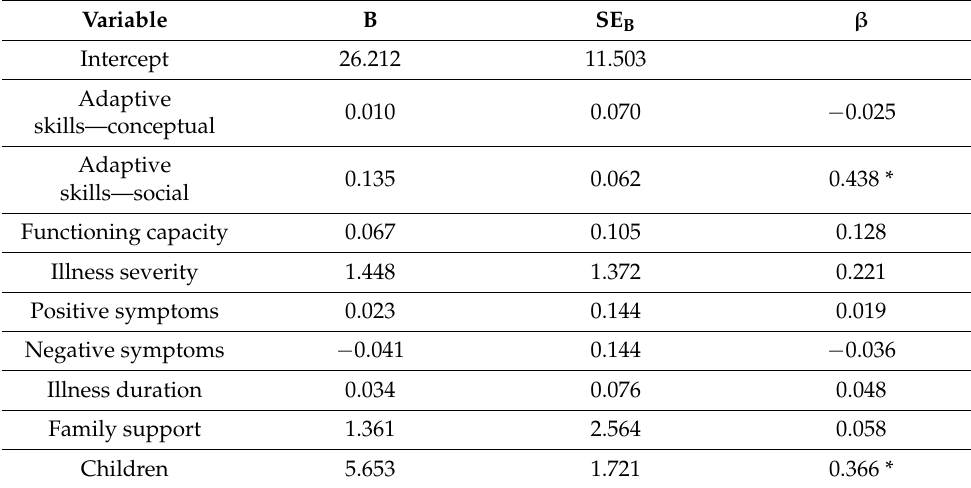
Table 5. Summary of the complete hierarchical multiple regression